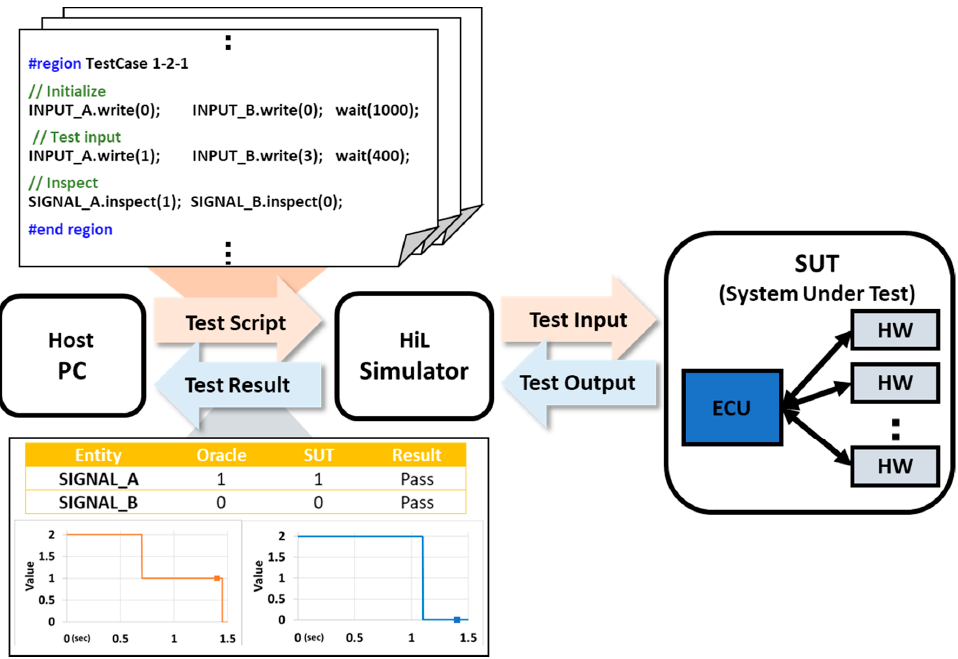
Figure 2. HiL test environment.